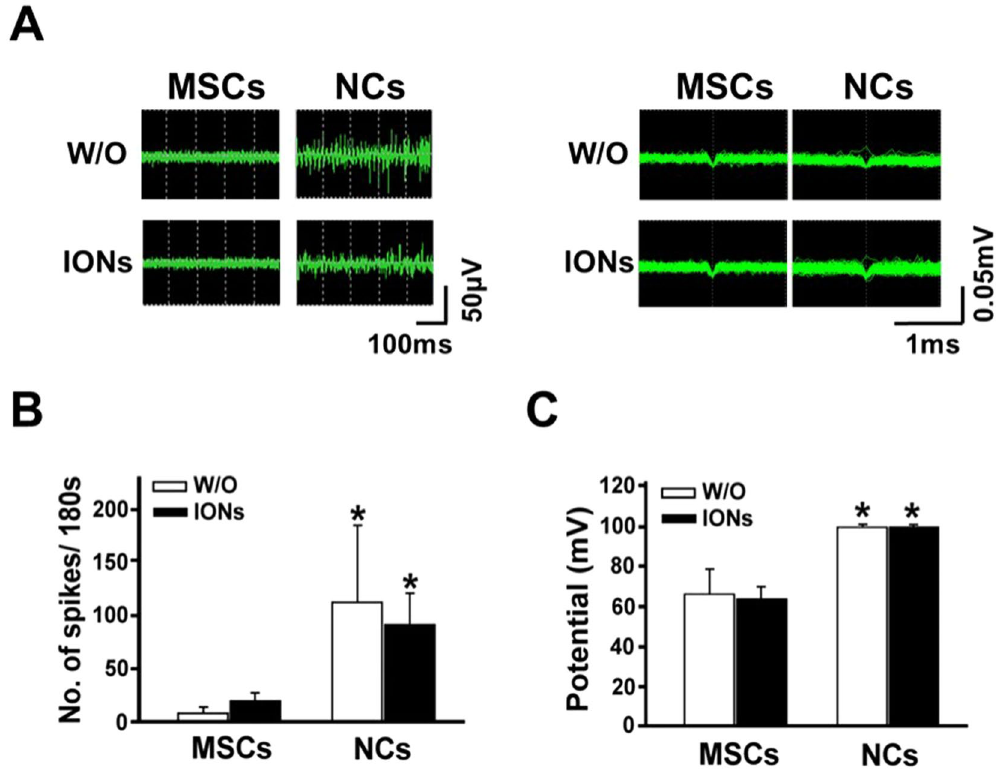
Figure 4. Action potentials of hMSCs, NCs with or without ION labelling. ( A ) Quantitative analysis of the action potentials (mV, millivolt; ms, milliseconds). ( B ) The number of spikes are reported. ( C ) Both action potential amplitude and the number of spikes increased after neural-like cell induction. ION labelling had no influence on the action potential amplitude or number of